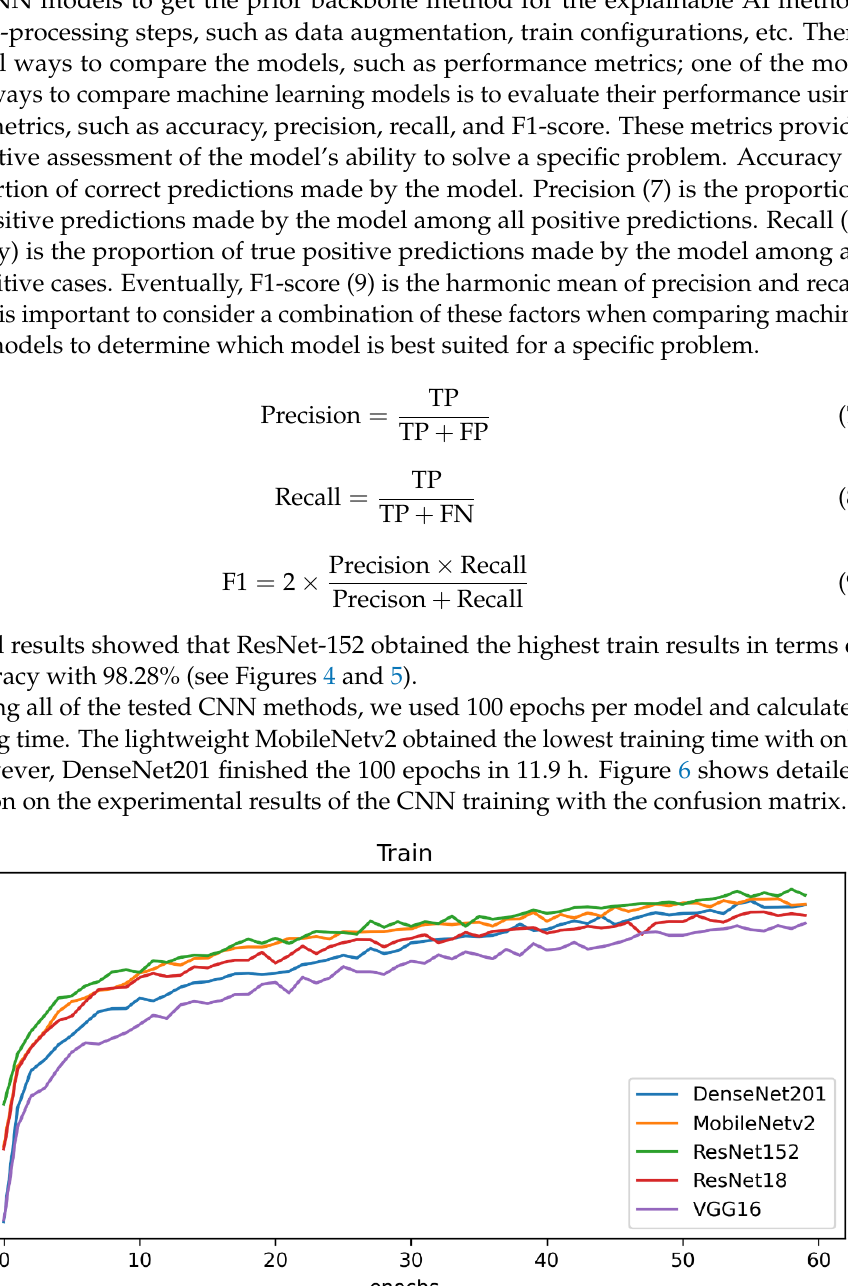
Figure 5. Validation accuracy of the CNN models for the backbone of explainable AI . Among all of the tested CNN methods, we used 100 epochs per model and calculated the training time. The lightweight MobileNetv2 obtained the lowest training time with only 6.1 h ; however, DenseNet201 finished the 100 epochs in 11.9 h . Figure 6 shows de- tailed information on the experimental results of the CNN training with the confusion matrix.